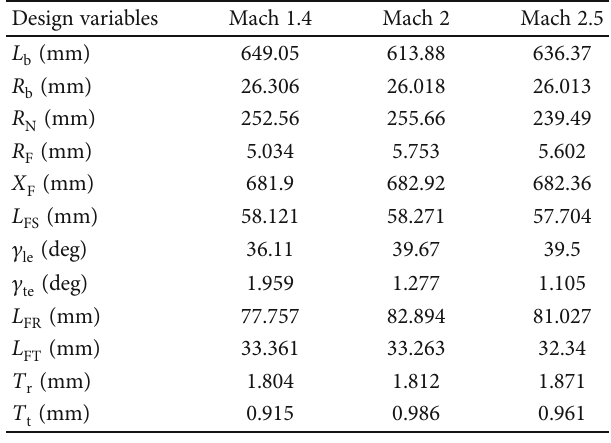
Table 4: Optimum shape size at 1.4, 2, and 2.5 Mach